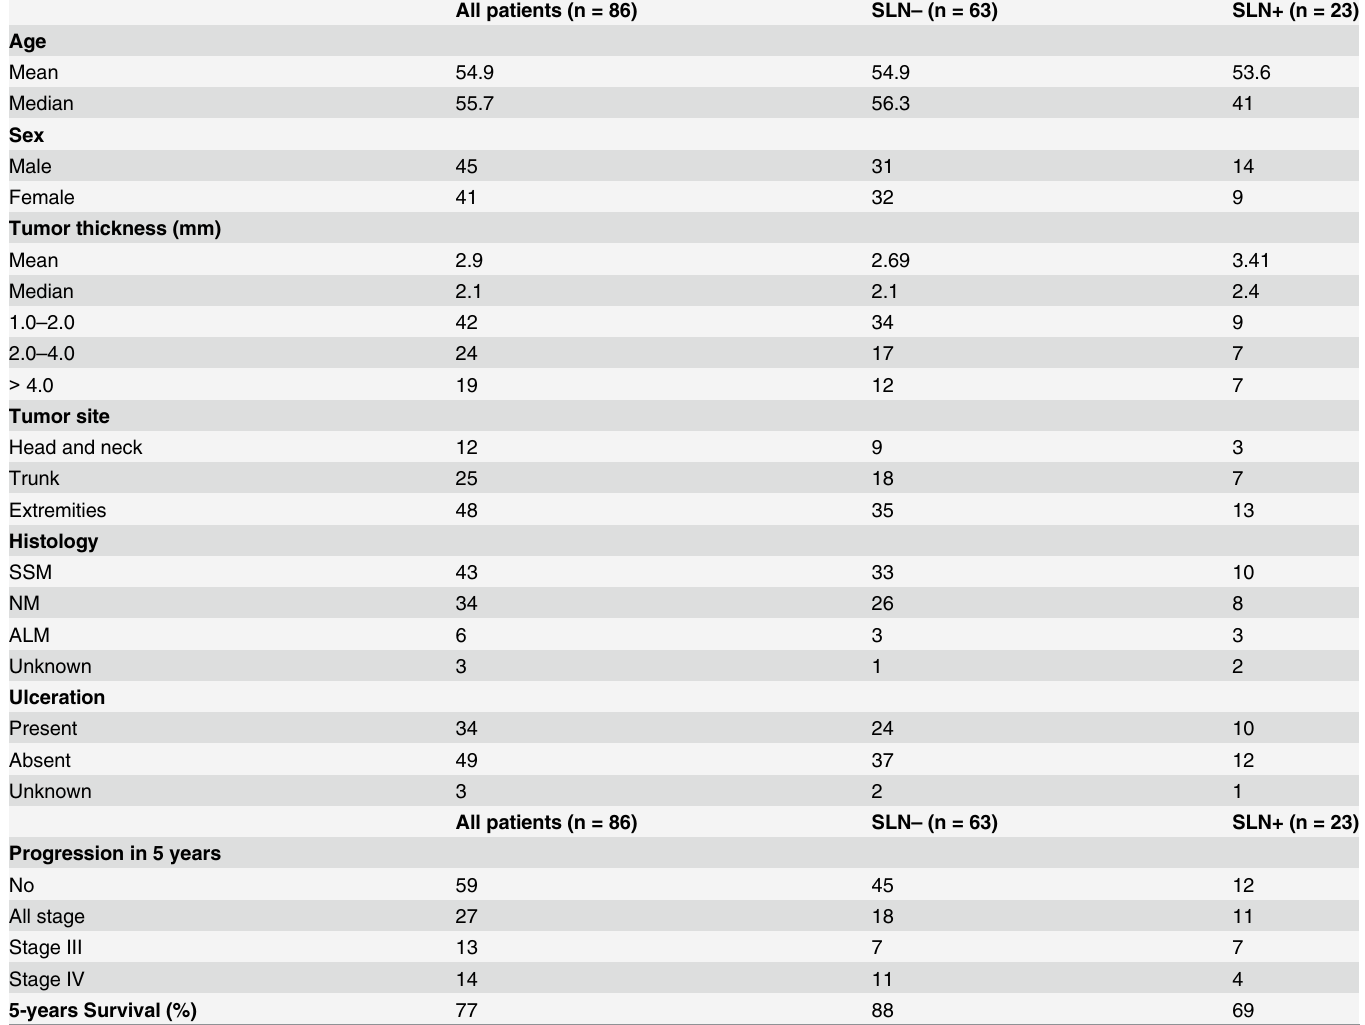
Table 2. Characteristics of the cutaneous tumors of the patients included in the SLN cohort and their clinical evolution over 5 years follow-up. SSM: Superficial Spreading Melanoma; NM: Nodular Melanoma; ALM: Acral Lentiginous Melanoma. All patients (n = 86) SLN – (n = 63) SLN+ (n =